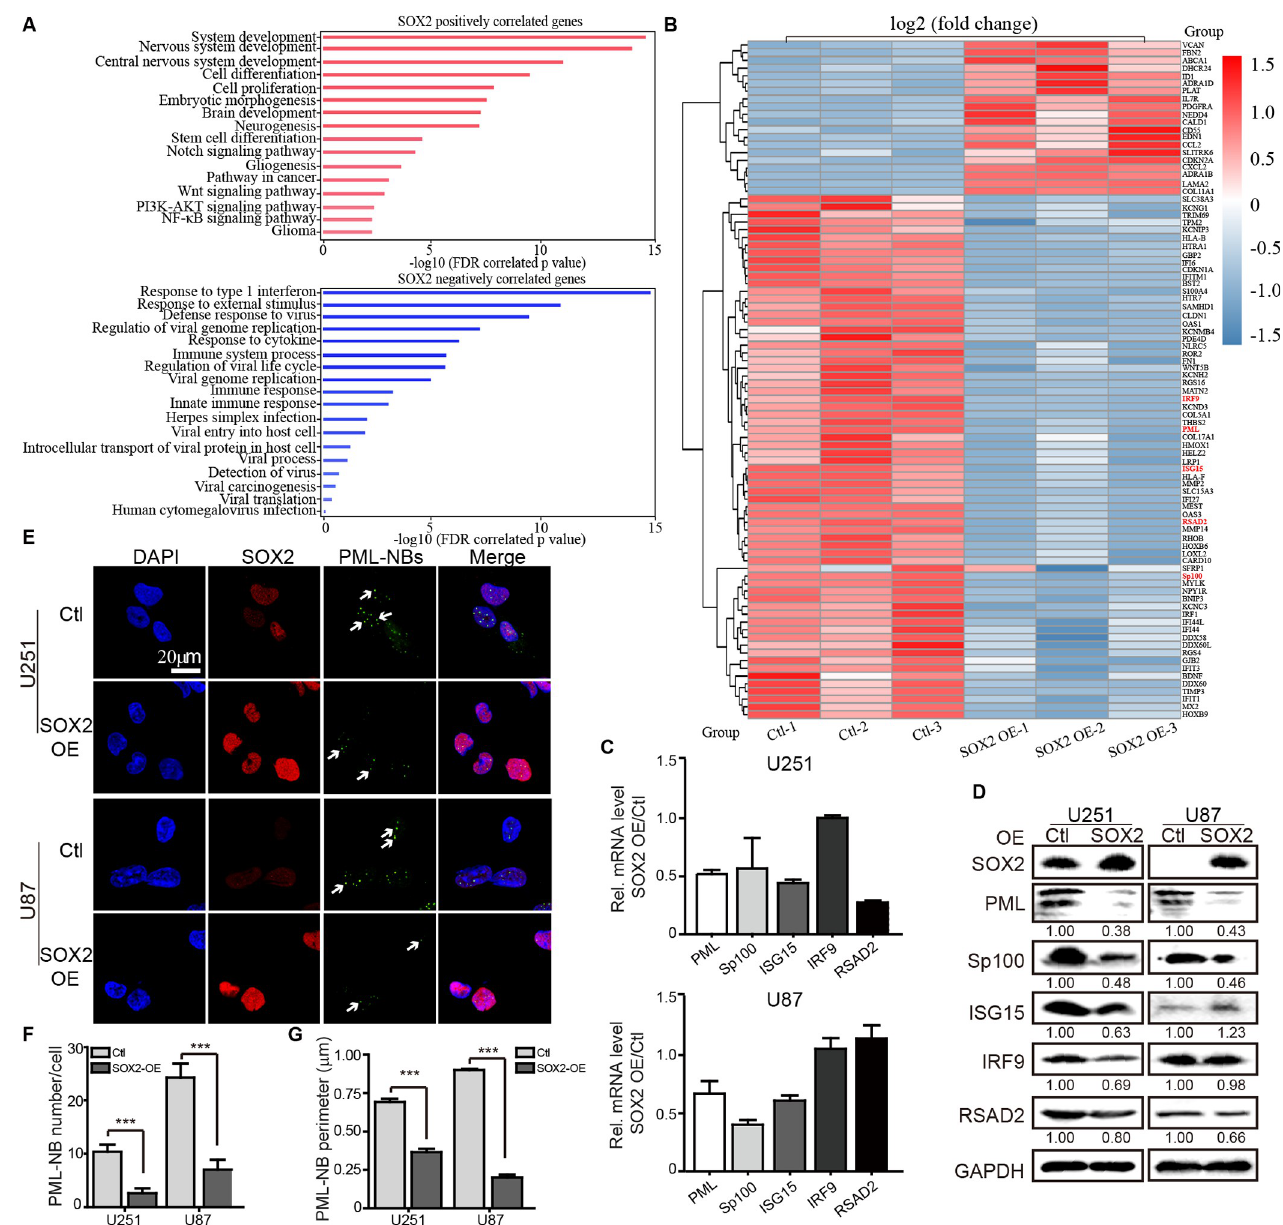
Fig 2. RNA-Seq analysis of SOX2-OE U251 cells. ( A ) Gene set enrichment analysis shows the top pathways positively or negatively correlated with SOX2-OE in U251 cells. ( B ) Heatmap of differentially expressed genes with function related to virus infection. The mRNA ( C ) and protein ( D ) levels of PML, Sp100, ISG15, IRF9, and RSAD2 in SOX2-OE and Ctl cells of U251 and U87. ( E ) PML-NBs. SOX2 (red) and PML (green) were detected by immunofluorescence analysis (IFA), and PML-NBs were indicated by white arrows. The number ( F ) and perimeter ( G ) of PML-NBs were quantified from 5 random fields in 50 cells. Data in ( C , F and G ) are from three independent experiments and represent as means ± SEM (Student’s t-test; * , p < 0.05; ** , p < 0.01; *** , p < 0.001).